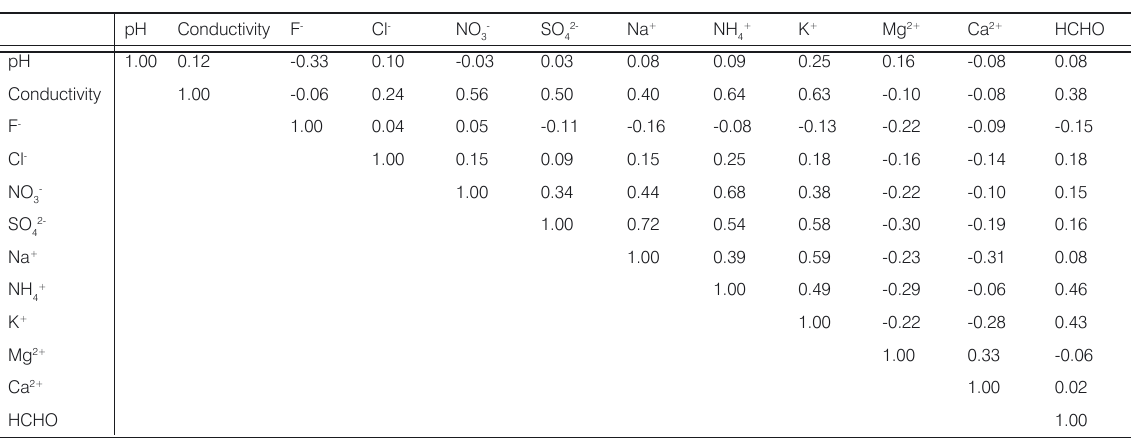
Table 4. Table of